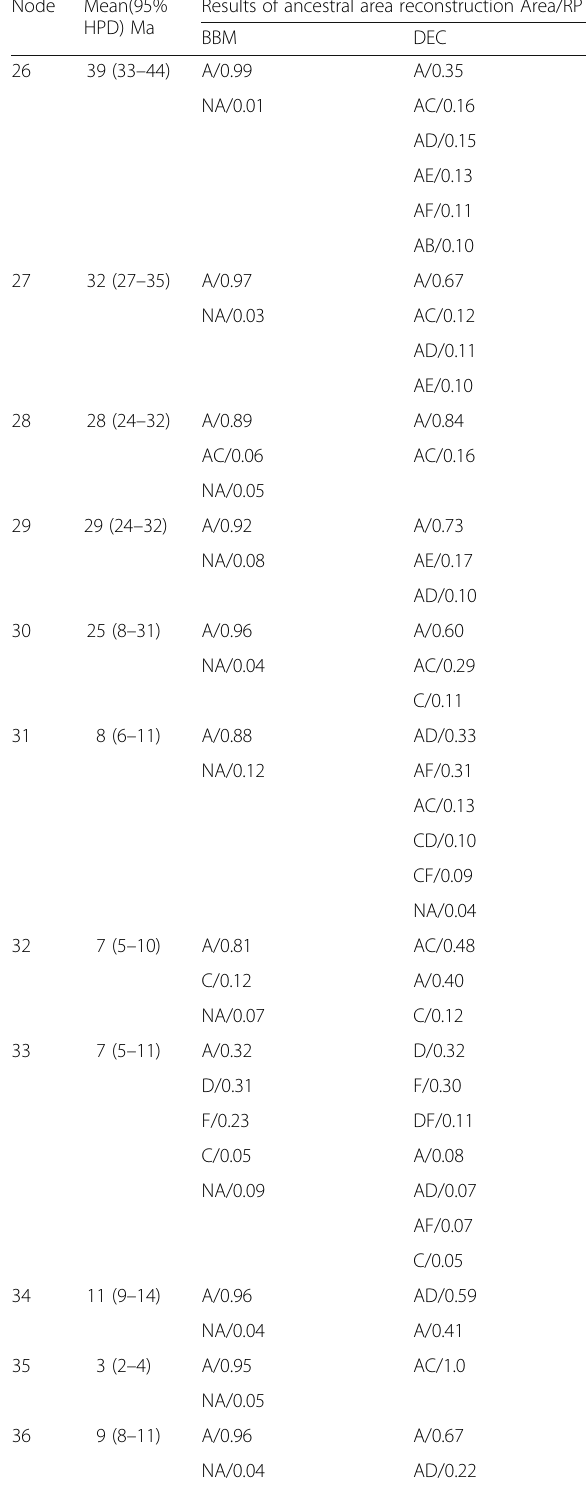
Table 3 Divergence time estimates of BEAST analyses for major nodes of Pleurotus ostreatus species complex